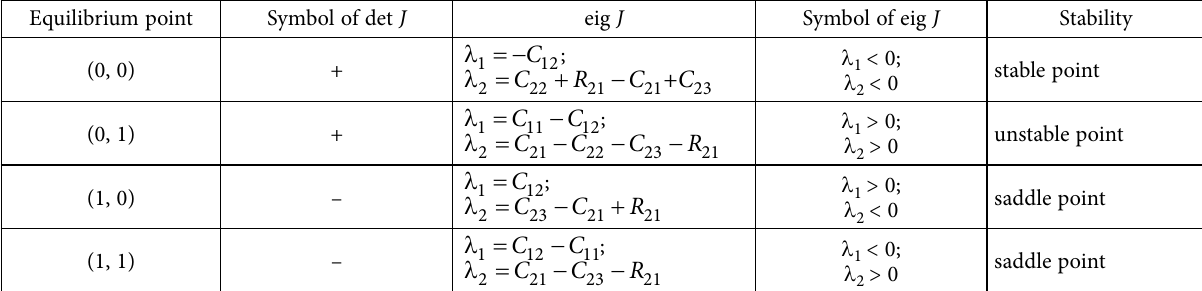
Table 3. The stability analysis of the evolutionary game based on Scenario 1 of Section 4.2 Equilibrium point